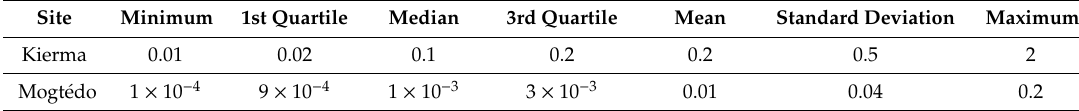
Table 3. Descriptive statistics of hydraulic conductivities in m / day.